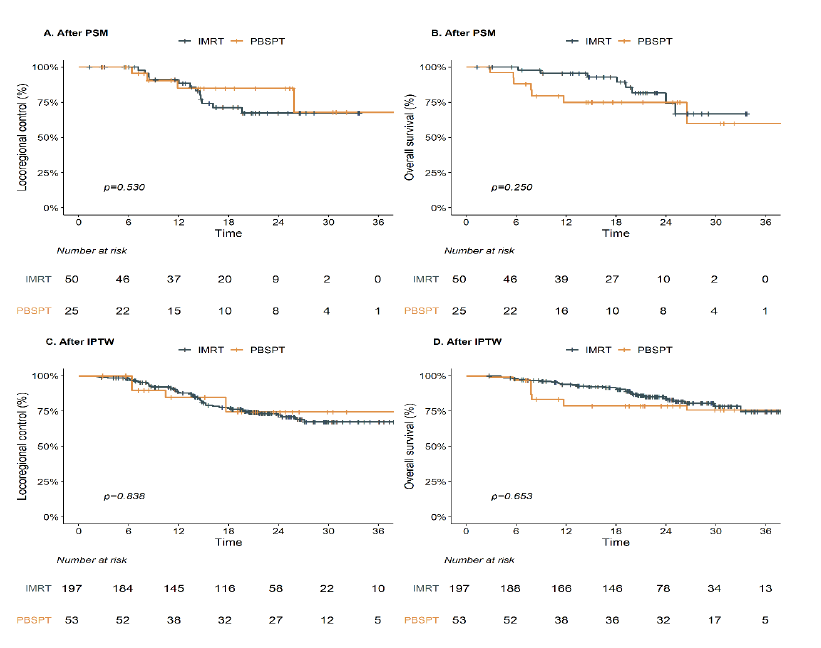
Figure 5. Clinical outcomes following IMRT and PBSPT after propensity score-adjusted analysis: LRC after PSM ( A ); OS after PSM ( B ); LRC after IPTW ( C ); OS after IPTW ( D ). Abbreviations: IMRT, intensity-modulated radiation therapy; PBSPT, pencil beam scanning proton therapy; LRC, locoregional control; OS, overall survival; PSM, propensity score matching; IPTW, inverse probability of treatment weighting.